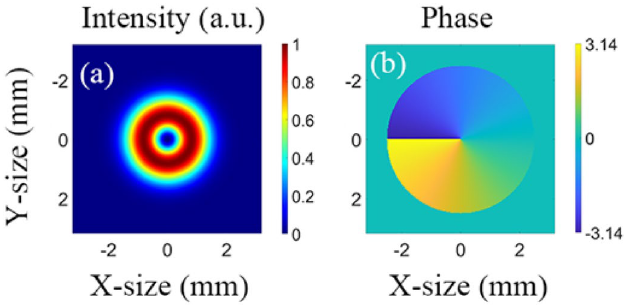
Figure 5. ( a ) Intensity distribution and phase distribution ( b ) of input ideal LG01 beam.